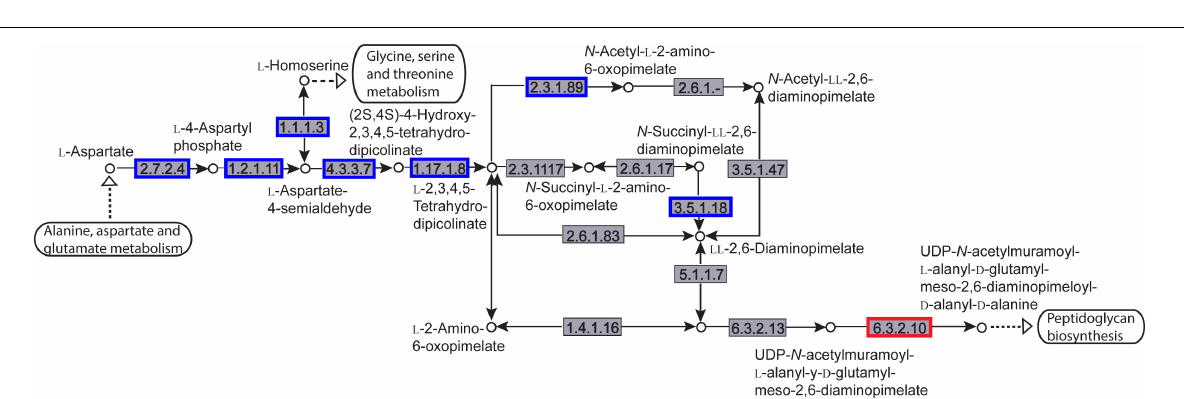
FIGURE 10 | Distribution of the differentially expressed genes (DEGs) in the sulfur metabolism pathway. Compared with the control group, an enzyme with a blue frame is related to a downregulated gene, an enzyme with a red frame is related to an upregulated gene. The number within the frames represents the enzyme code.